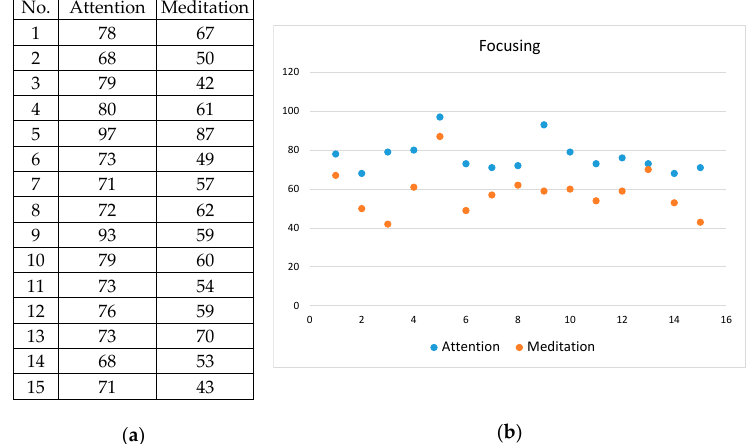
Figure A1. The data and the distribution graph of the average values of the 15 measured two-feature sample sequences of the emotion type of focusing, from which the corresponding decision rule a ≥ 70 and a ≥ m for emotion classification was inferred, where m and a represent the meditation and attention signals, respectively. ( a ) The average data. ( b ) The distribution graph.